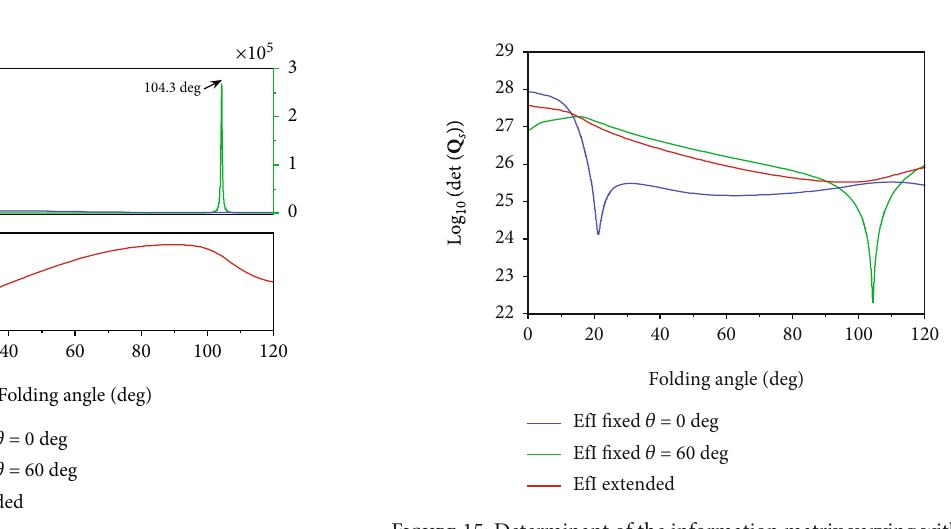
Figure 13: Optimal sensor placement layouts by the e ff ective independence (EfI) method. (a) Fixed con fi gurations. (b) Integrating all con fi gurations.